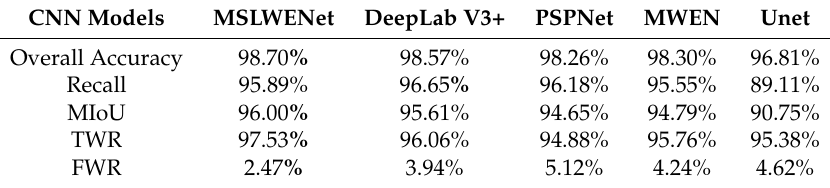
Table 3. The metrics of the CNN models on the images in Figure